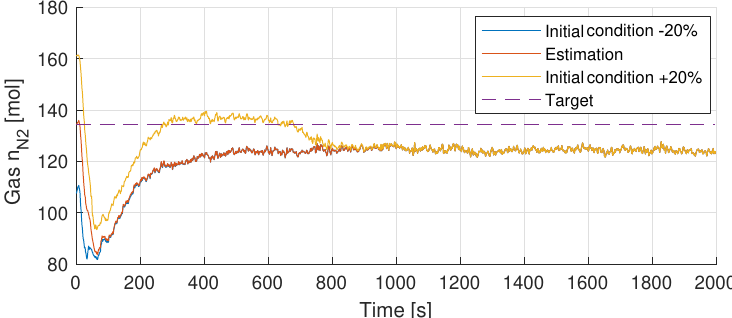
Figure 12. Estimated and experimental molar value for the low-load test sequence at different initial conditions. The accumulator is pre-charged to 125 bar/134 mol.